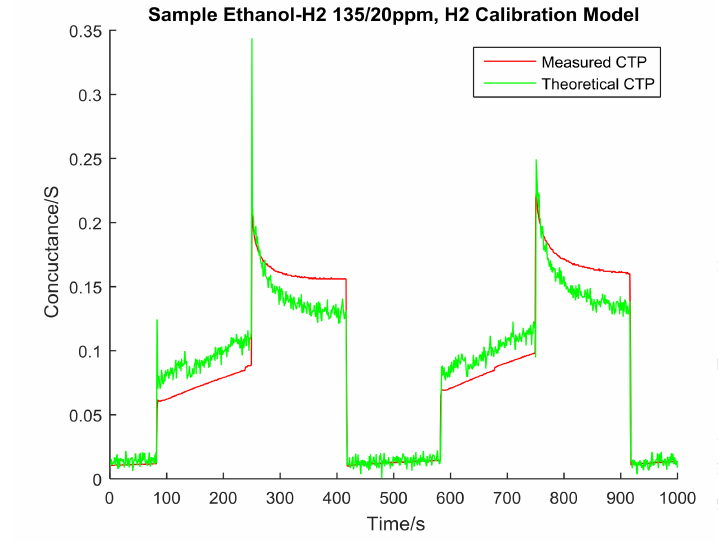
Figure 4. Comparison of measured CTP of a binary ethanol/H 2 mixture and the related theoretical CTP based on the H 2 calibration